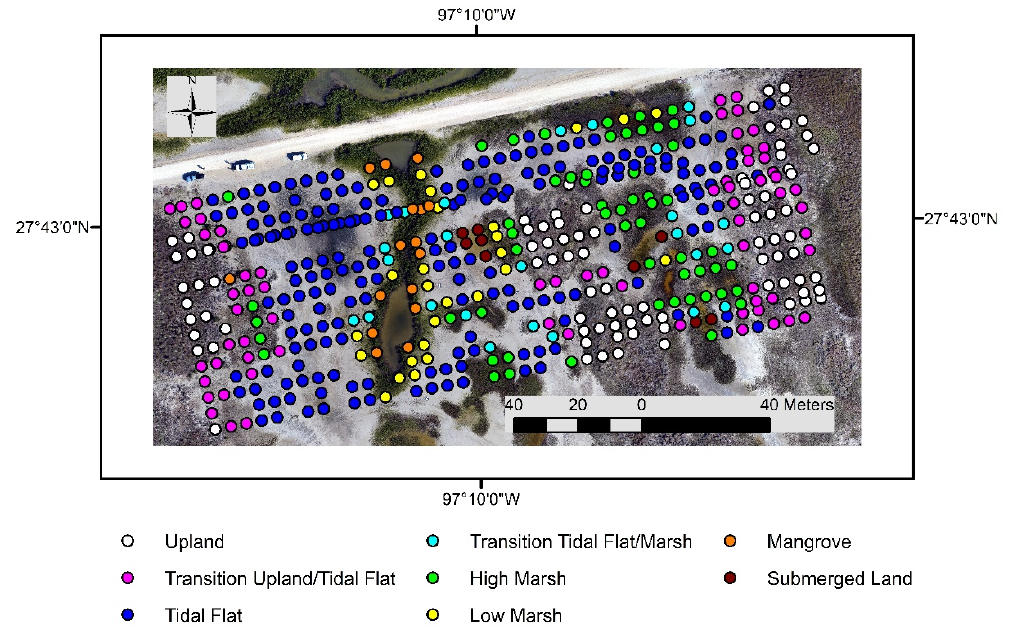
Figure 3. Real-time kinematic (RTK) survey points overlaid on an unmanned aircraft system (UAS) background image showing distribution of RTK points collected for each marsh environment.